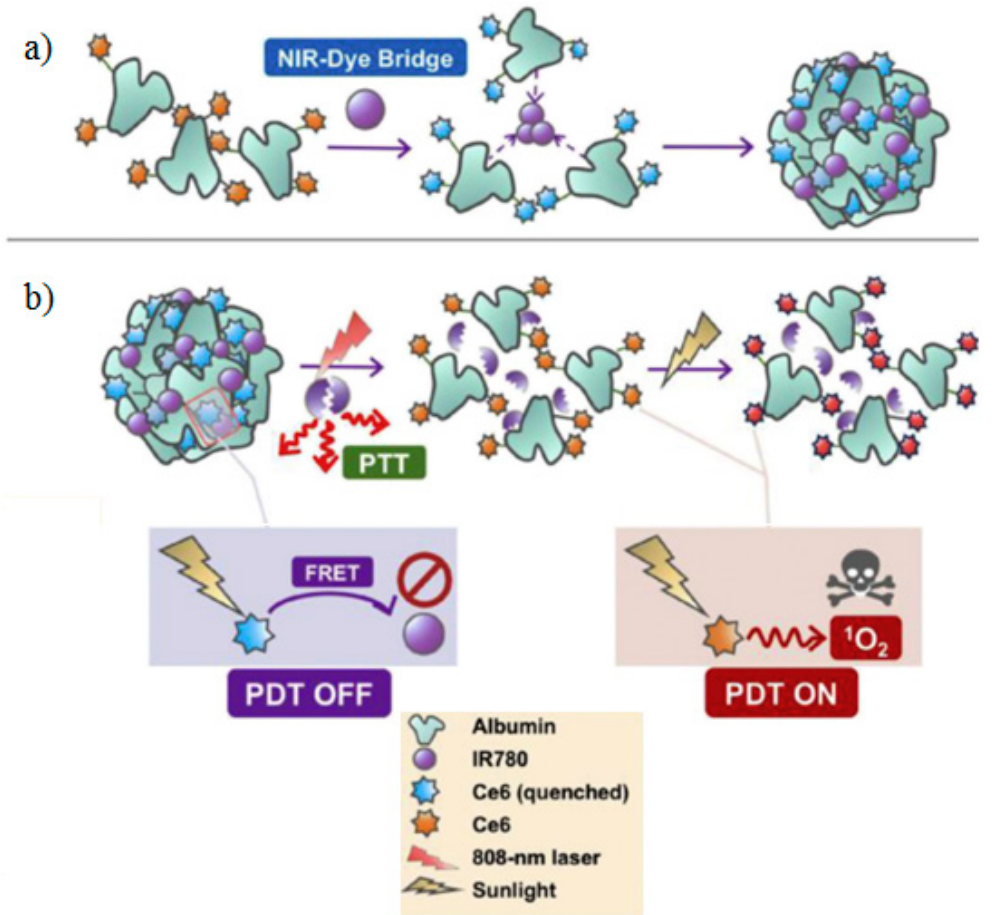
Figure 6. The scheme of switchable photodynamic therapy (Switch-PDT). ( a ) Schematic of self-assembly of albumin-Ce6 conjugates into NP induced by a NIR-dye bridge. ( b ) Schematic illustrating the quench effect of IR780 on Ce6 photosensitization (PDT OFF) and recovery of the photosensitization under 808-nm laser irradiation (PDT ON). Reprinted from Biomaterials, Yifan Zhang et al., Switchable PDT for reducing skin photosensitization by a NIR dye inducing self-assembled and photo-disassembled nanoparticles, 23–32, Copyright (2016), with permission from Elsevier [184].